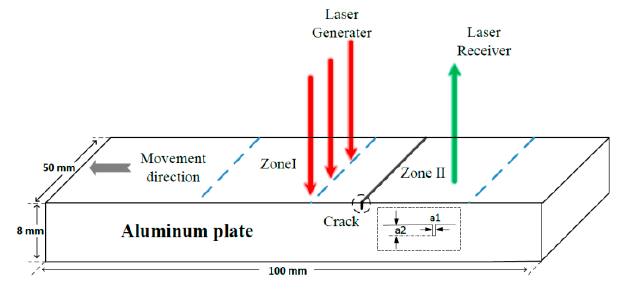
Figure 9. Schematic diagram of scanning-laser-source technology device.